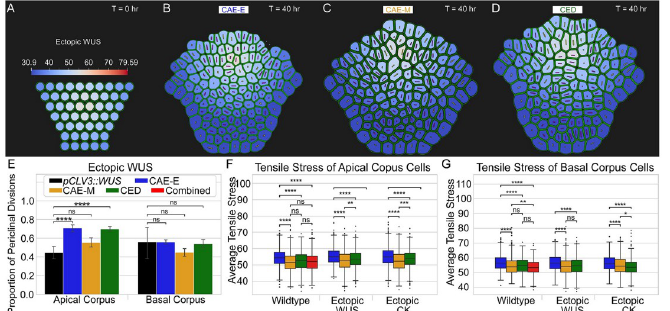
Fig 7. Quantitative comparisons of experimental data with simulation results for ectopic misexpression of WUS. (A) Initial levels and spatial pattern of WUS were calibrated to be analogous with ectopic misexpression of WUS experiments. The maximum WUS concentration was decreased to 2/3 wildtype concentrations and its spatial distribution was expanded in the corpus (see the “Model description” section for details). (B-D) Final time point of ectopic WUS simulations for all three mechanisms. (E) Proportion of periclinal divisions for three mechanisms compared to experiments in ectopic misexpression of WUS simulations. Average tensile stress on the cell wall for all three mechanisms in (F) the Apical corpus and (G) Basal corpus for wildtype, for wildtype, ectopic CK, and ectopic WUS simulations. Significance tests in (E-G) were performed using independent t-tests. Asterisks indicate significance at the following levels: � (p � 0.05), �� (p � 0.01), ��� (p � 0.0001), ���� (p � 0.00001), ns (p > .05). S4 Fig provides extended analysis between ectopic misexpression of WUS SAMs in experiments and simulations for all four hypothesized mechanisms presented in this